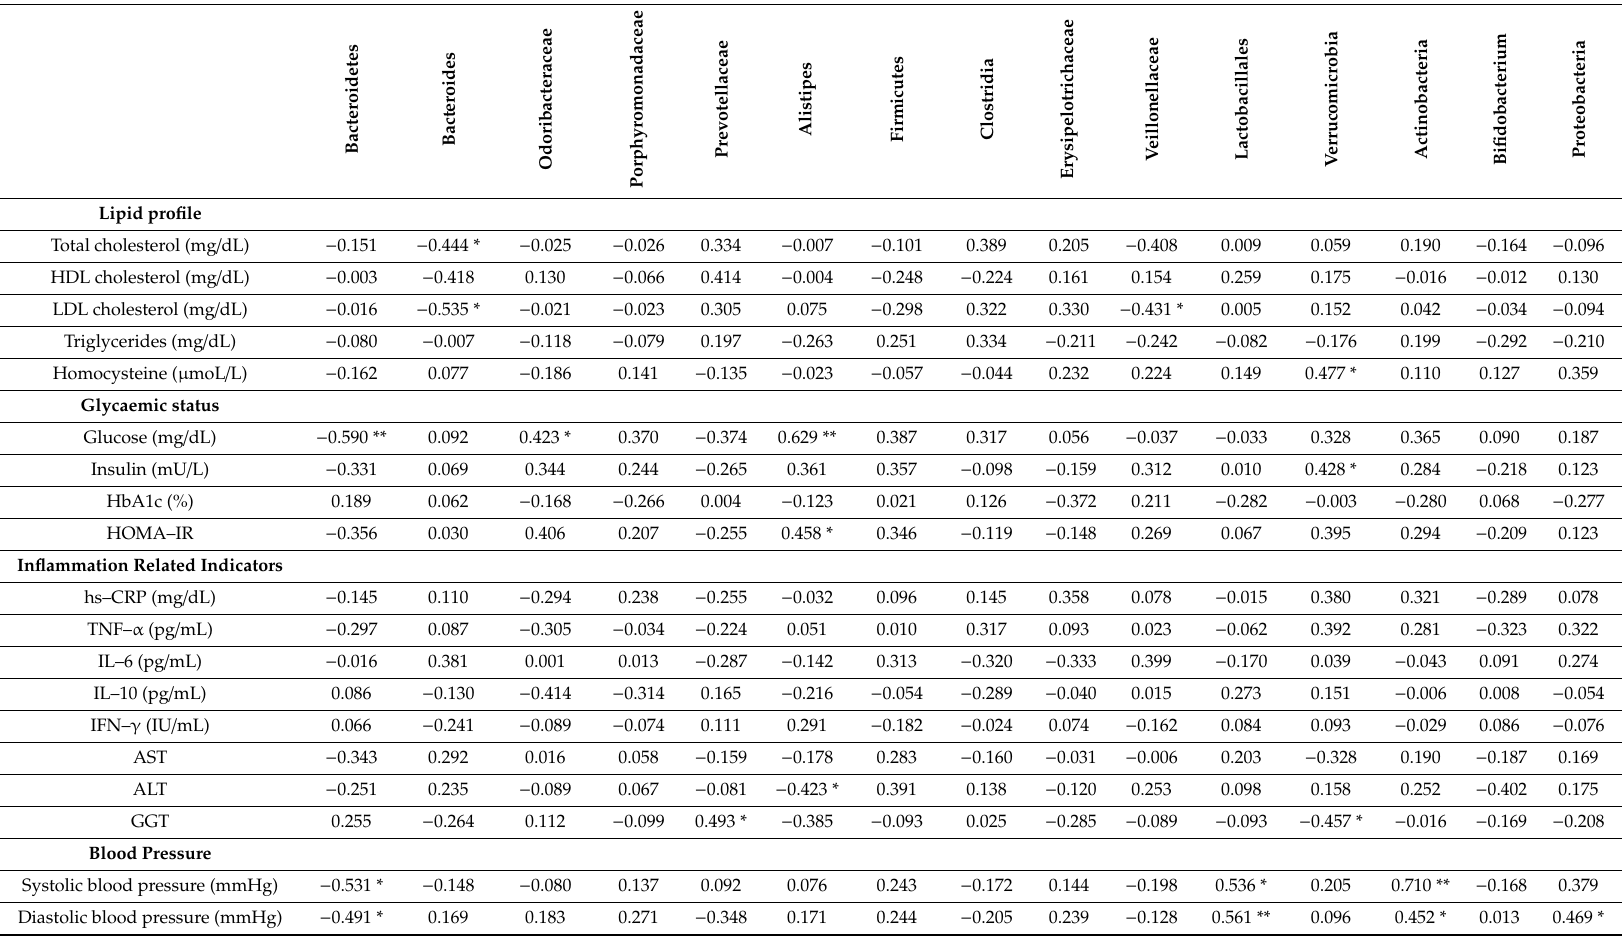
Table 4. Correlations between changes in biochemical markers and fecal microbiota composition at phylum and sub–phylum level (cid:44)